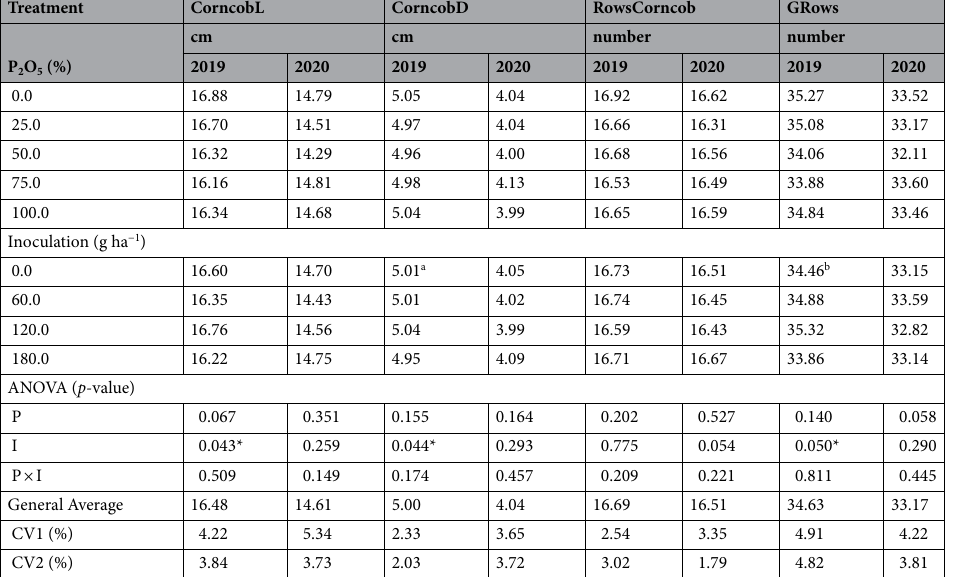
Table 3. Corncob length (CorncobL), corncob diameter (CorncobD), number of rows per corncob (RowsCorncob), and number of grains per row (GRows) as a function of added amounts of P 2 O 5 and inoculant containing Rhizophagus intraradices . CV: coefficient of variation (%). *significant at 5% by the F Test (ANOVA). a y = − 0.000006x 2 + 0.000777x + 5.0062 (R 2 = 0.7262). b y = − 0.00013x 2 + 0.02123x + 34.36400 (R 2 = 0.8412).